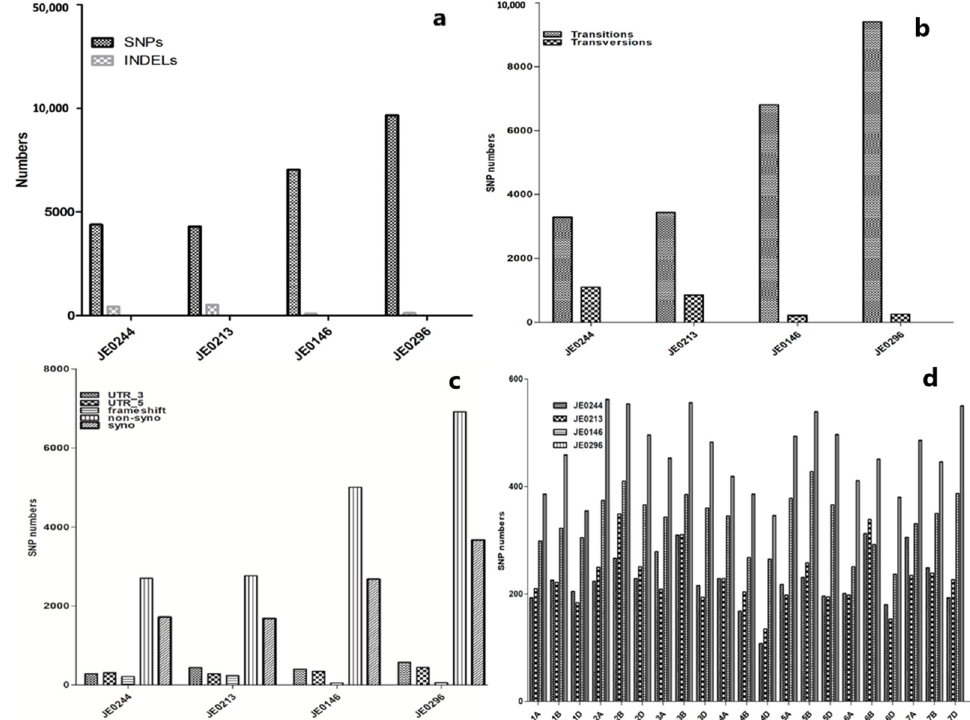
Figure 7. Identification of mutations in the four mutant lines (JE0244, JE0213, JE0146, and JE0296): ( a ) SNPs and Indels; ( b ) transition and transversion mutants in the four mutants; ( c ) Syno, Nsyno, UTR_3, UTR_5, and frameshift mutations; and ( d ) the number of mutations in four mutant lines in the A, B, and D